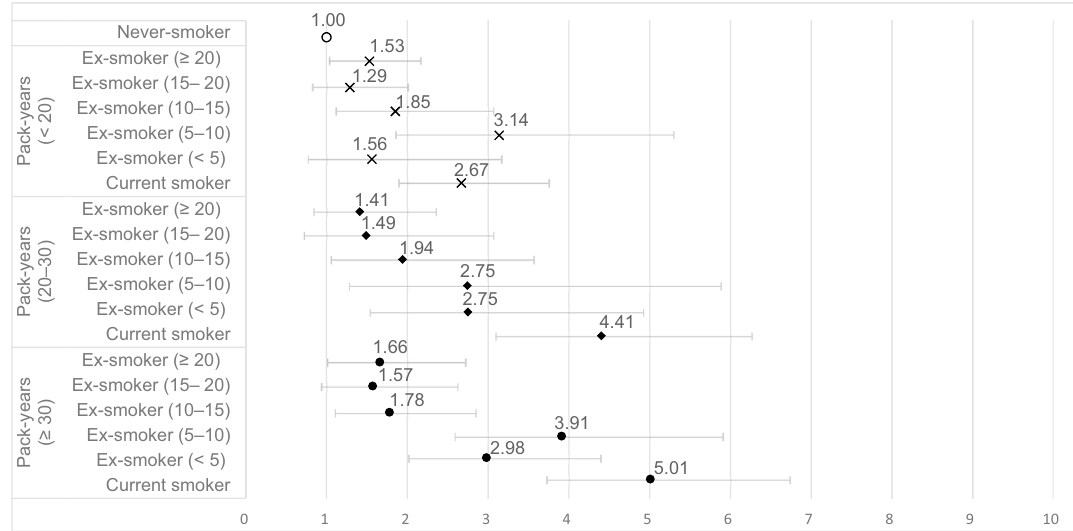
Figure 1. Association between smoking cessation status and obstructive spirometry pattern according to the cumulative smoking exposure in men. Adjusted for age, educational level, household income, occupation, residential area, physical activity, high-risk drinking, and height.